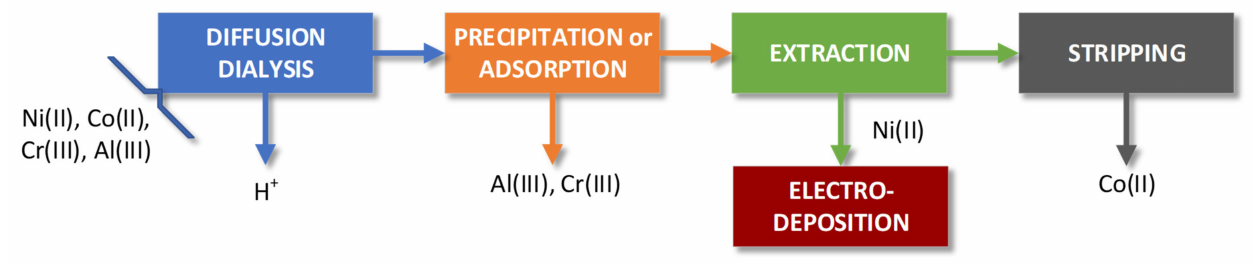
Figure 1. Scheme of the proposed hydrometallurgical